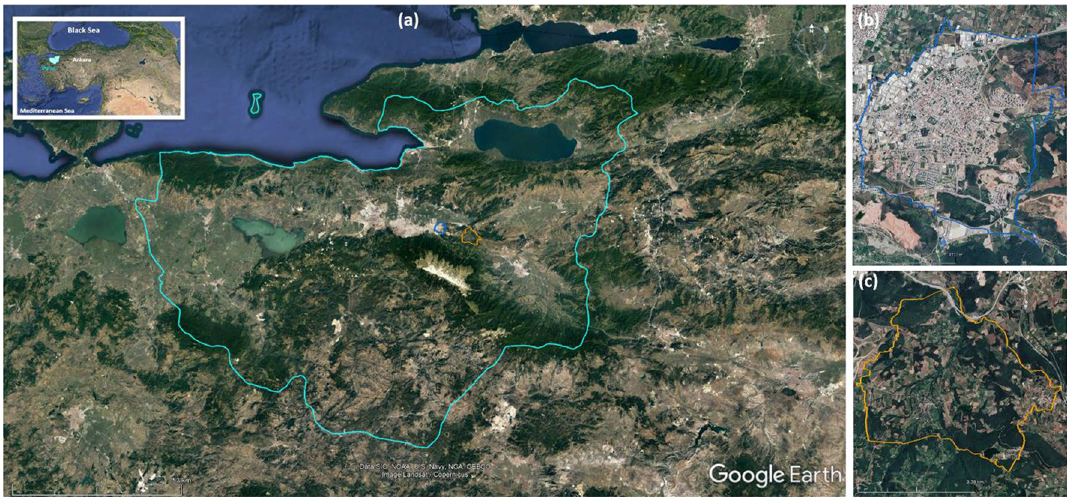
Figure 1. Map of the location of Bursa region in Turkey and two study sites in Bursa. ( a ) Bursa region, ( b ) Kestel, and ( c )